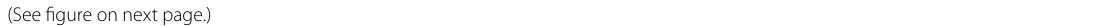
figure on next Fig. 3 Assessment of roughness of tibial cartilage. Mice were subjected to a sham procedure or transection of the medial collateral and anterior cruciate ligaments (ACLT) or ACLT followed by transection of the medial meniscus (MNCT). Groups were sacrificed 7 or 14 days post surgery. a Data represent mean sem of cartilage roughness (µm) using scanning electron microscope (SEM) images (9/group), compared using Student’s “t” test. ± Representative SEM imaging and roughness plots of the tibial cartilage of animals of the sham [ b , h and e , q ], ACLT [ c , i and f , l ], and MNCT [ d , j and g , m ] groups sacrificed at 7 or 14 days post surgery,